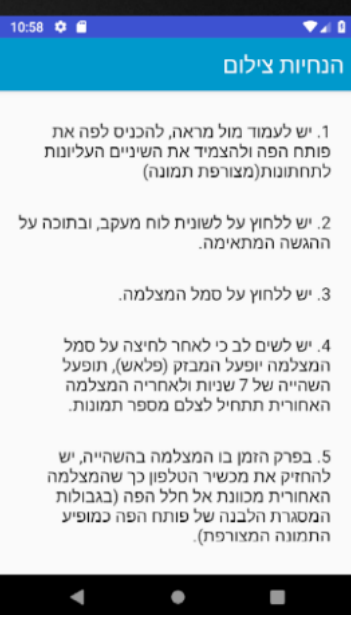
Figure 12. Tutorial screen for the patient: photo guidelines.